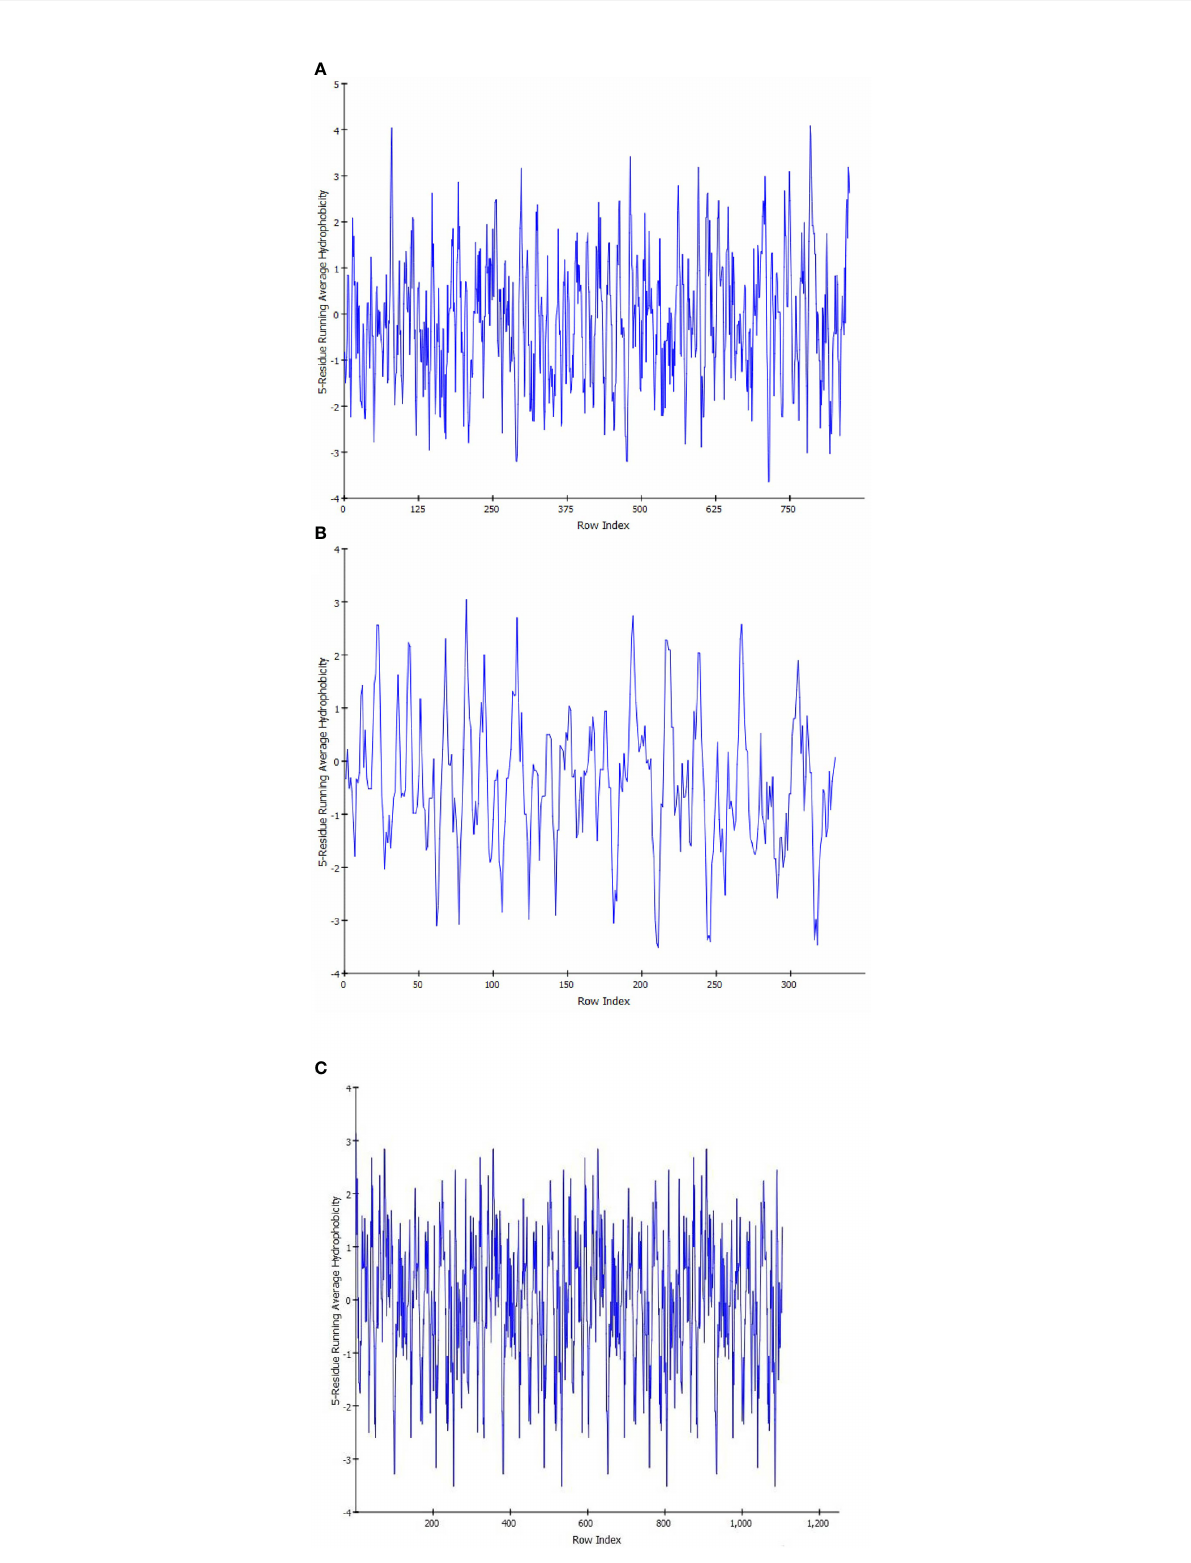
FIGURE 2 Hydropathy analysis showing the inclusion of hydrophilic and hydrophobic sections in the amino acid chain, beginning at the N terminal and progressing to the C terminal in target protein PIK (A) , AKT (B) , and HER2 (C)